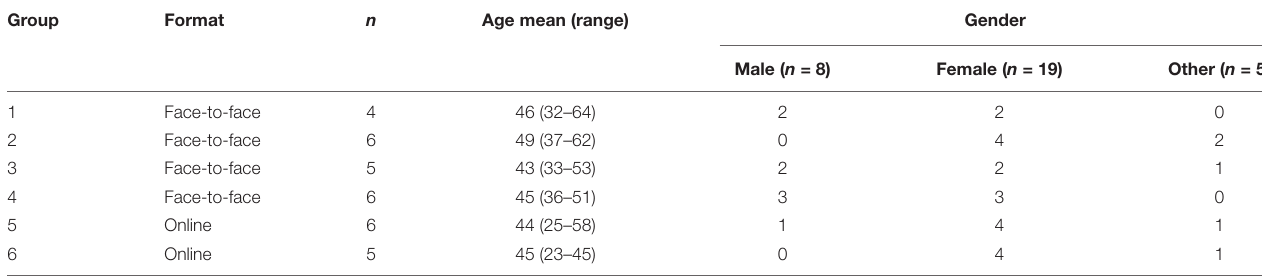
TABLE 1 | Focus group composition.